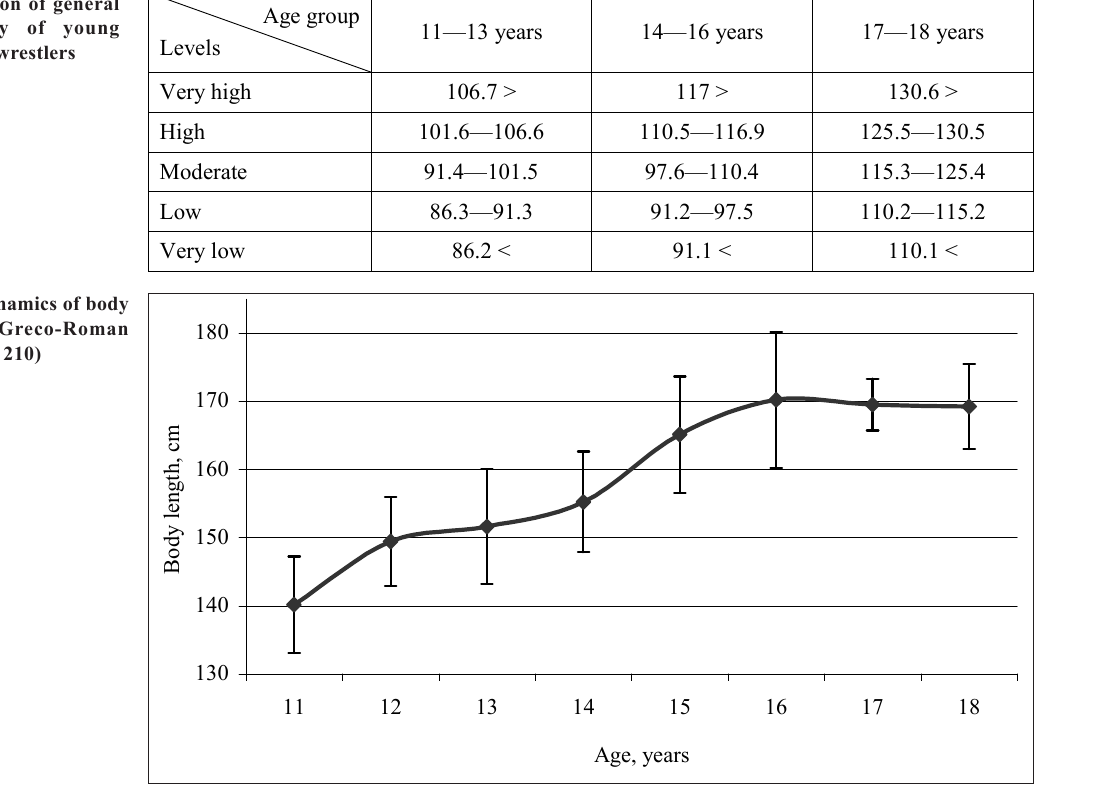
Fig. 3. Age dynamics of body length of Greco-Roman wrestlers (n =